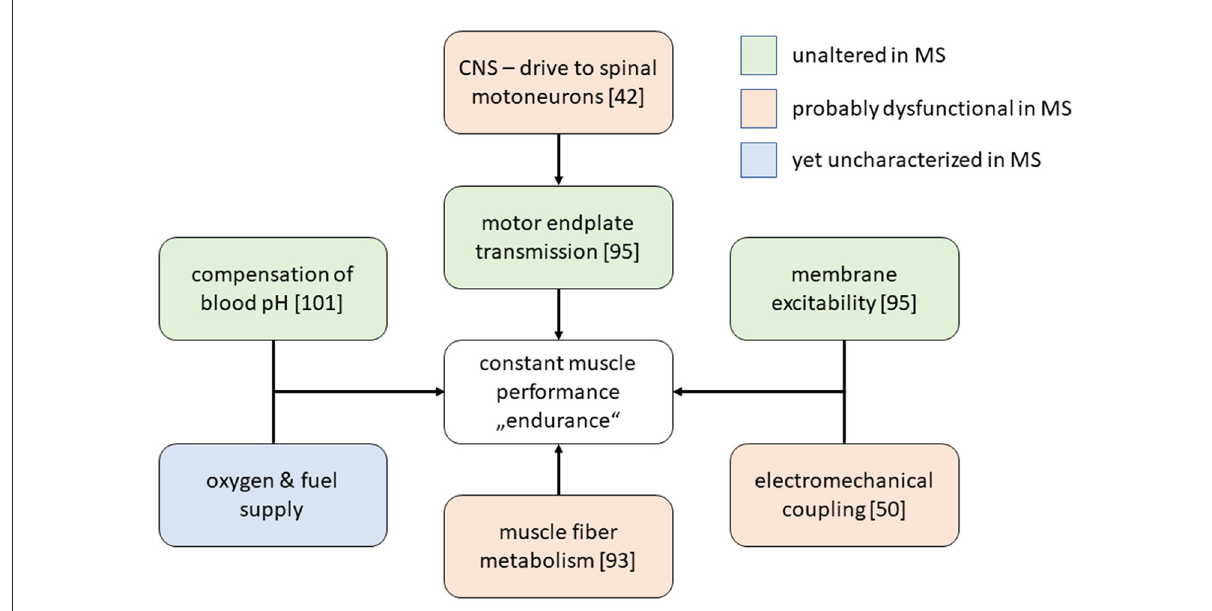
FIGURE1 Selected physiological processes that are required to maintain stable muscle force production. Among MS-patients, most of these processes have been described in MS patients samples and, according to the given in the figure legend, were found to be altered or not. The metabolic integration between muscle, liver and other organs during exercise has not yet been characterized thoroughly by appropriate experiments in MS patients.